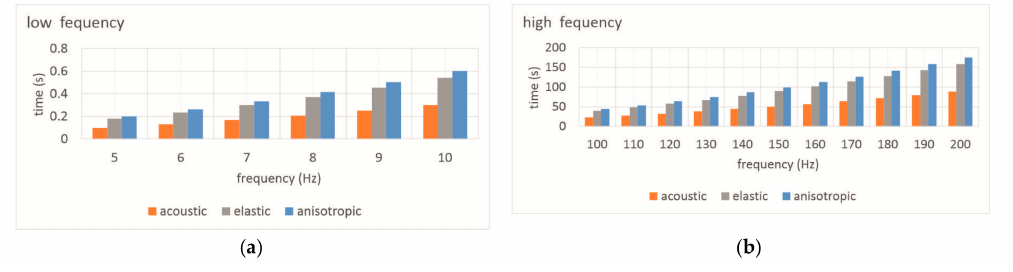
Figure 15. The execution time computed for di ff erent source frequency for: low ( a ) and high ( b ) frequencies of the source